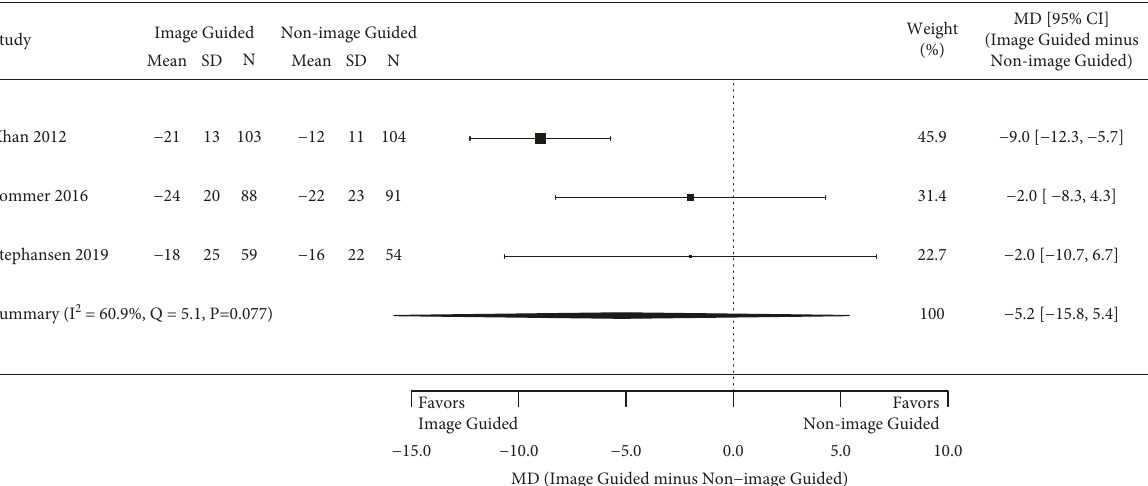
Figure 4: Mean relative reduction in LVEDV at 6 months.